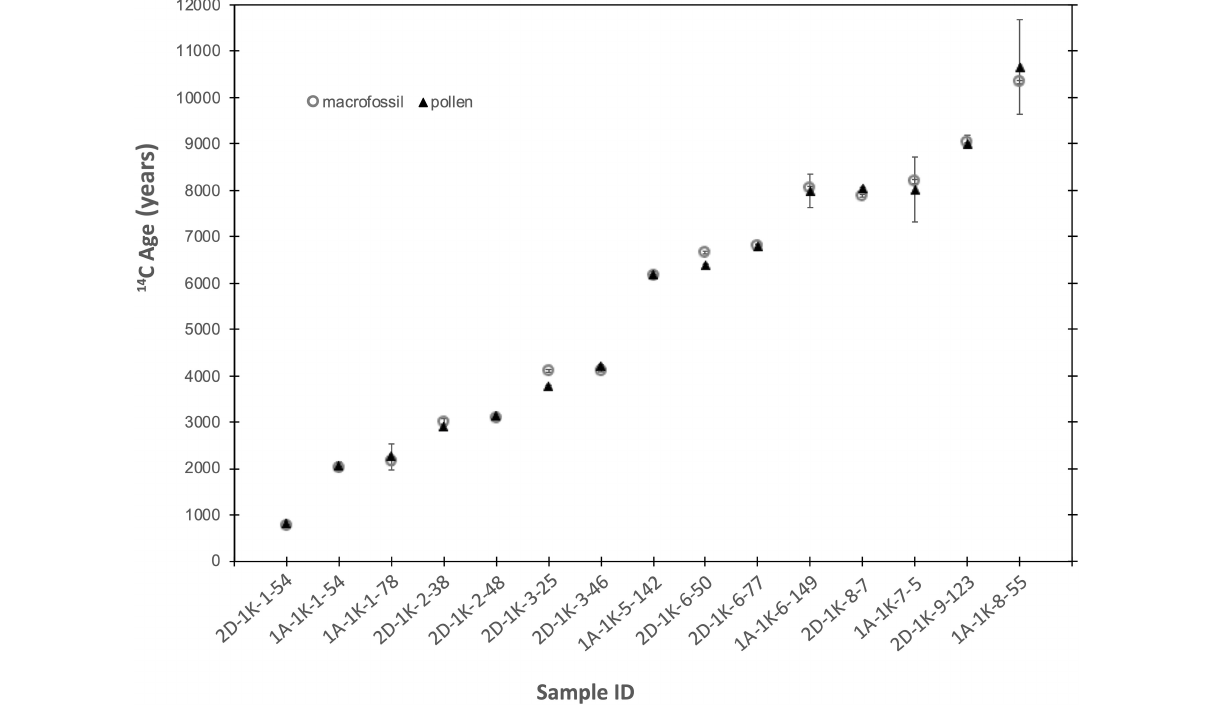
Frontiers in Ecology and Evolution |